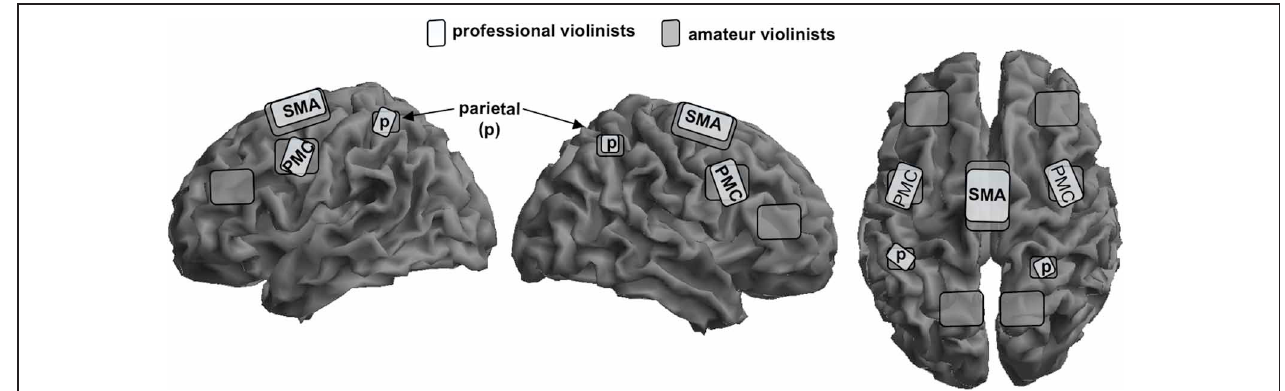
FIGURE 1 | Schematic overlay of mental rehearsal of playing a violin concerto only with the left hand in professional violinists (bright gray) and amateur violinists (dark gray) on a segmented gray matter cortex. Professionals focus their activation patterns on the bilateral superior parietal cortex, p; bilateral premotor cortex, PMC; and to a lower